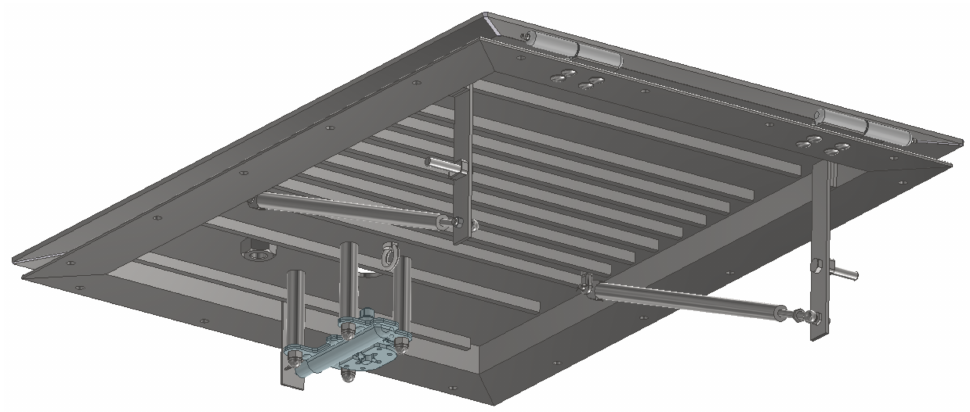
Figure 5. View of hinges with lubricator used on the